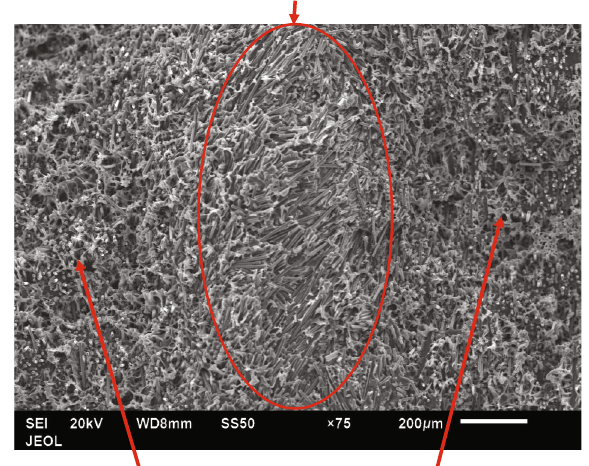
Fiber on the skin oriented parallel to the fracture surface Figure 10: SEM image of tensile fracture surface PP/40SCF at low magni fi cation (loading and injection molding direction perpendicular to the fracture